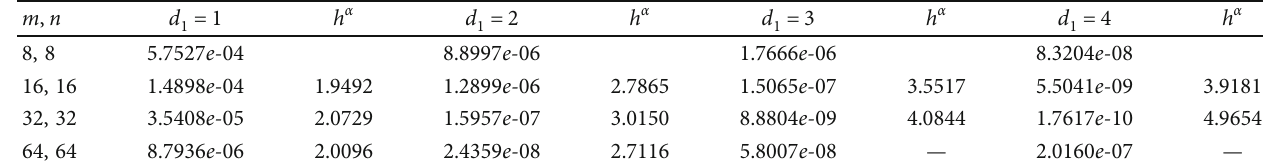
= 7 at t = 1 for Chebyshev nodes. 2